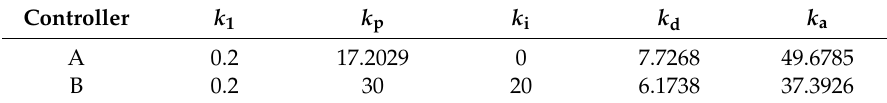
Table 3. Optimized controller parameters of non-recurrent single-objective PSO.